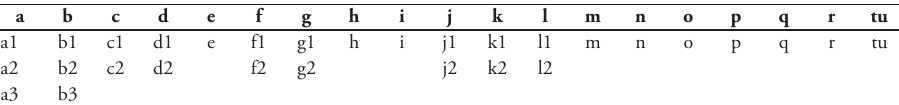
table 2. The chromosomal arms of the common shrew in alphabetical order (top line), without s (Y1). Homology to the elements of the Sorex ancestral karyotype, AKPS, is indicated in the rows below. Num- ber of ancestral homologous elements that formed present-day arms through past fusions was identified by G-banding and chromosome painting by Biltueva et al.